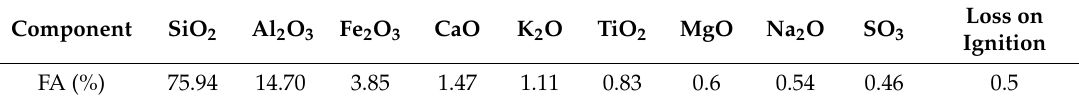
Table 2. Components of fly ash (FA).